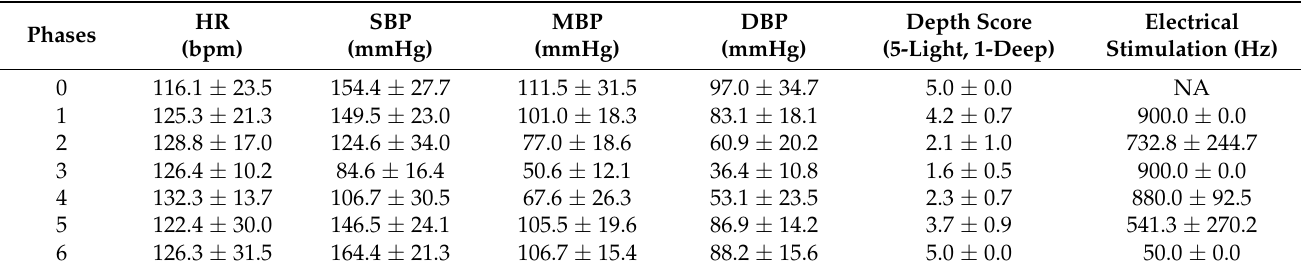
Table 2. Cardiovascular parameters (heart rate—HR, systolic blood pressure—SBP, mean arterial blood pressure—MBP, diastolic blood pressure—DBP), subjective anesthetic depth score (depth score), and tolerance to electric stimulation during 7 phases of propofol anesthesia in 6 dogs. The values are presented as mean ( ± SD). See Table 1 legend for the meaning of all 7